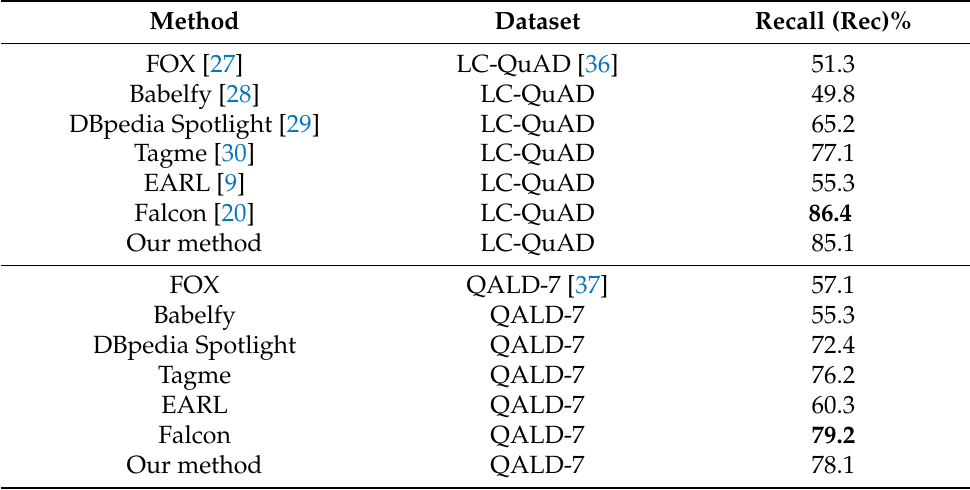
Table 1. Performance of our method compared to various entity-linking tools.